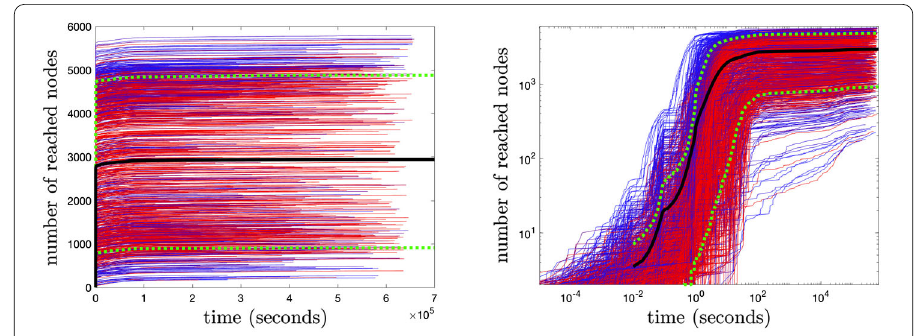
Figure 2 Blocks propagation. Number of nodes reached by a new valid block before a following block is discovered (left). The colours are associated with the size of the block: the size increases passing from blue to red. The black line is the average of all the observations and the two dashed green lines are respectively the 10% (lower) and 90% (upper) percentiles. The right plot the same of the left one but in log–log scale